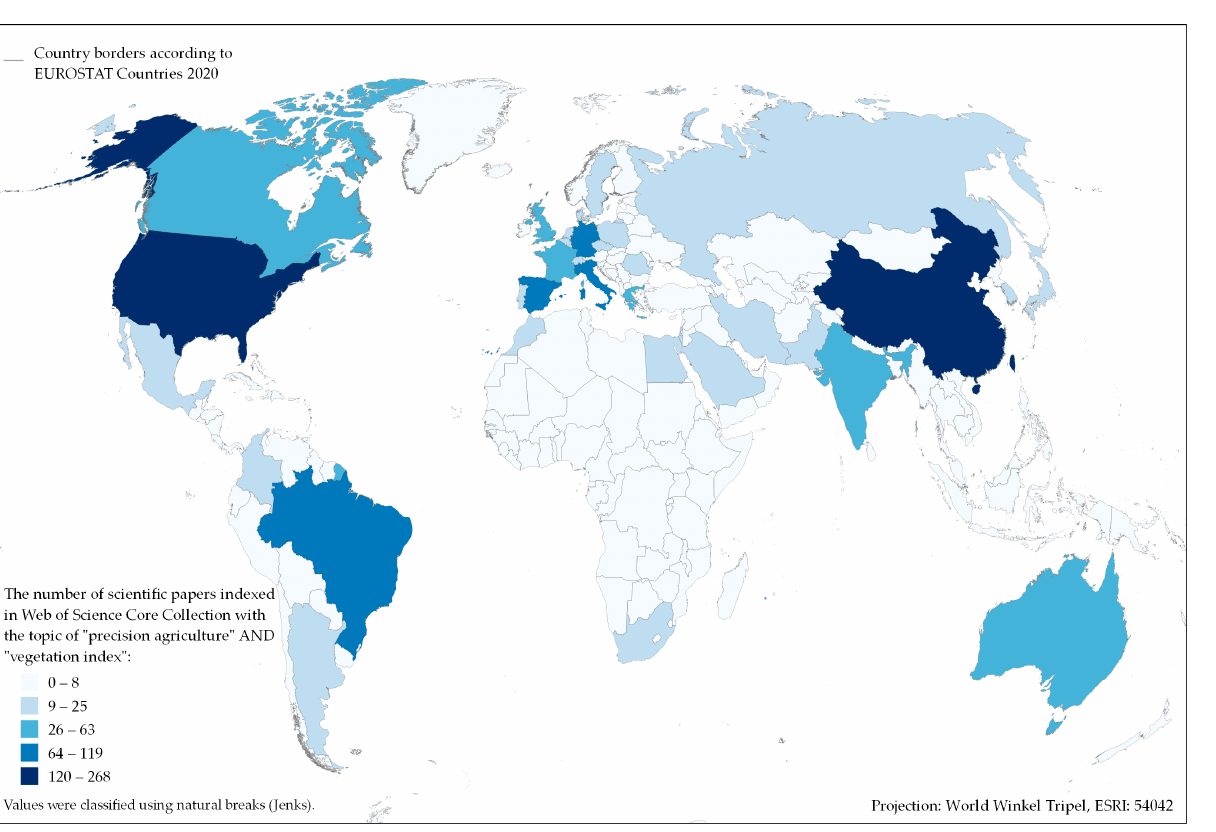
Figure 4. Global map of the percentage of scientific papers indexed in WoSCC since 2010 with the topic of “precision agriculture” AND “vegetation index” from the overall number of studies with the topic of “precision agriculture”.